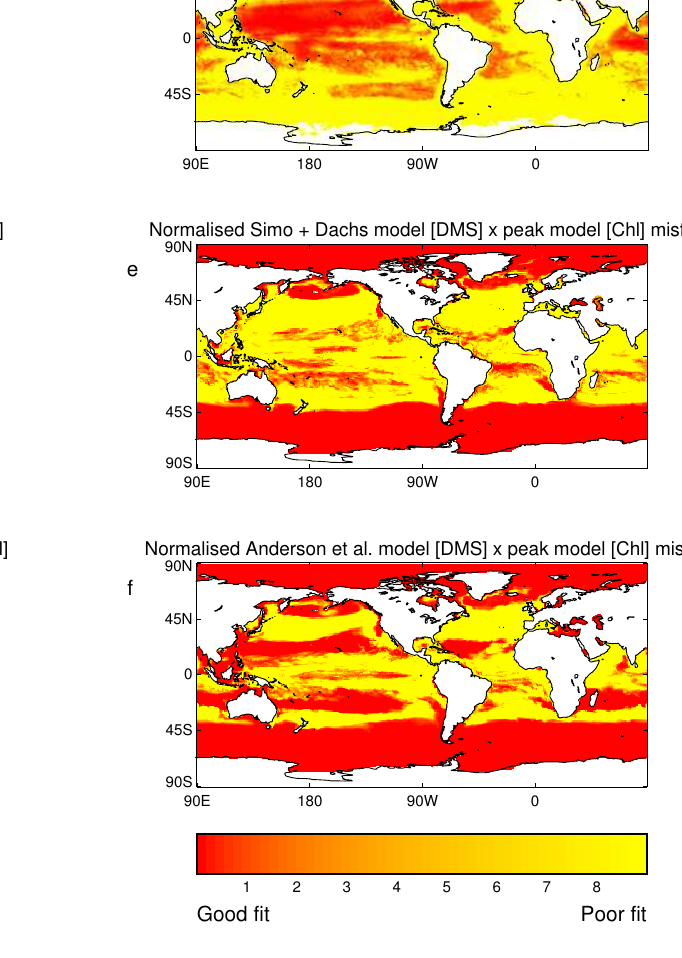
Fig. 3. (a–c) Lag (number of days) between peak chlorophyll and peak DMS concentrations, comparing; (a) SeaWiFS (Yoder and Kennelly, 2005) chlorophyll and Kettle climatology DMS, and model DMS and chlorophyll fields calculated using (b) the modified Simo (2002) scheme and (c) the Anderson (2001) scheme. Colours correspond to the number of days between DMS and chlorophyll concentration peaks. Peaks have been calculated by fitting a sine curve through an averaged 12 months of data at each grid point (or a minimum of six months of data in the case of SeaWiFS (Yoder and Kennelly, 2005)), and therefore assume a sinusoidal seasonal cycle. The colour correlation between the Kettle climatology – SeaWiFS plot (a) and the model plots (b, c) indicate the success of the model at reconstructing the non-linearity between primary production and DMS production, and allow us to examine the “summer paradox”. (d–f) Quantification of the misfit between the calculated sine curves and the data, highlighting where the assumption of a sinusoidal seasonal cycle is (red), and is not appropriate (yellow). Colours represent the value of the average normalised DMS misfit at each point, multiplied by the average normalised chlorophyll misfit at each point. The multiplication of normalised misfit values for DMS and chlorophyll cause a strong polarisation between areas represented as demonstrating good fit (red) and areas demonstrating poor-fit 24